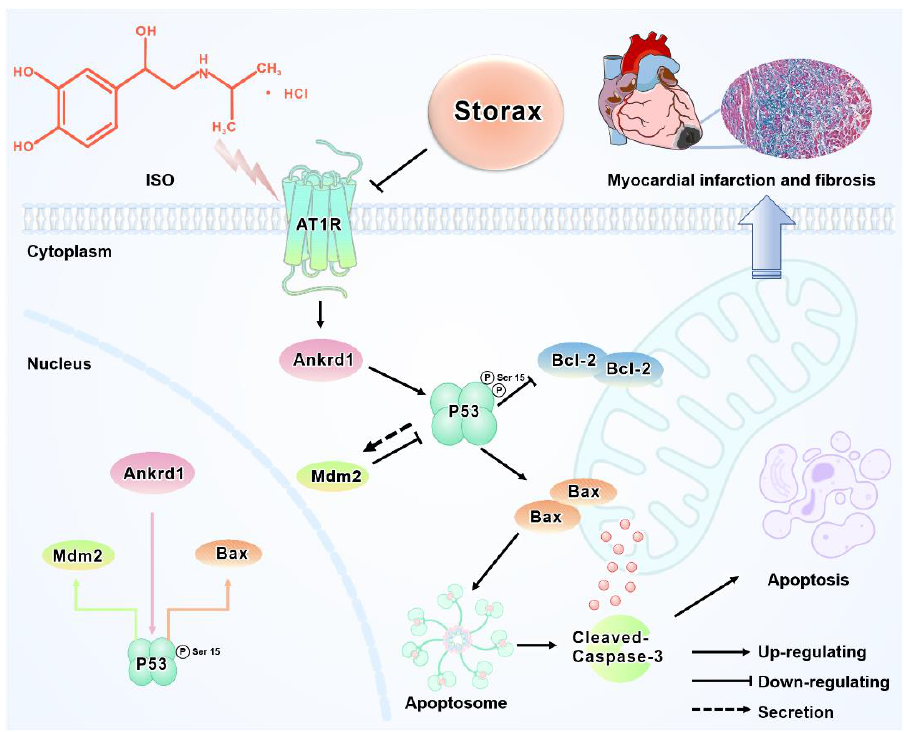
Figure 9. The underlying mechanisms of the cardioprotective activity of storax against ISO-induced AMI in rats. ISO-induced myocardial infarction can activate the AT1R – Ankrd1 – P53 signaling path- way, thereby inducing cardiomyocyte apoptosis. Storax intervention effectively inhibited the AT1R– Ankrd1–P53 signaling pathway to suppress cardiomyocyte apoptosis and improve post-infarction myocardial fibrosis.